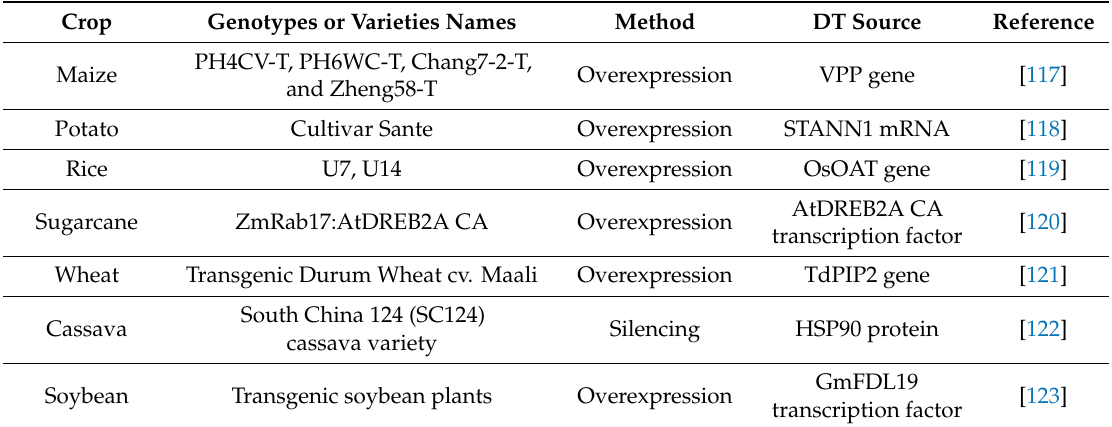
Table 3. Examples of the contribution of genomic approaches in the breeding of major crops for drought tolerance